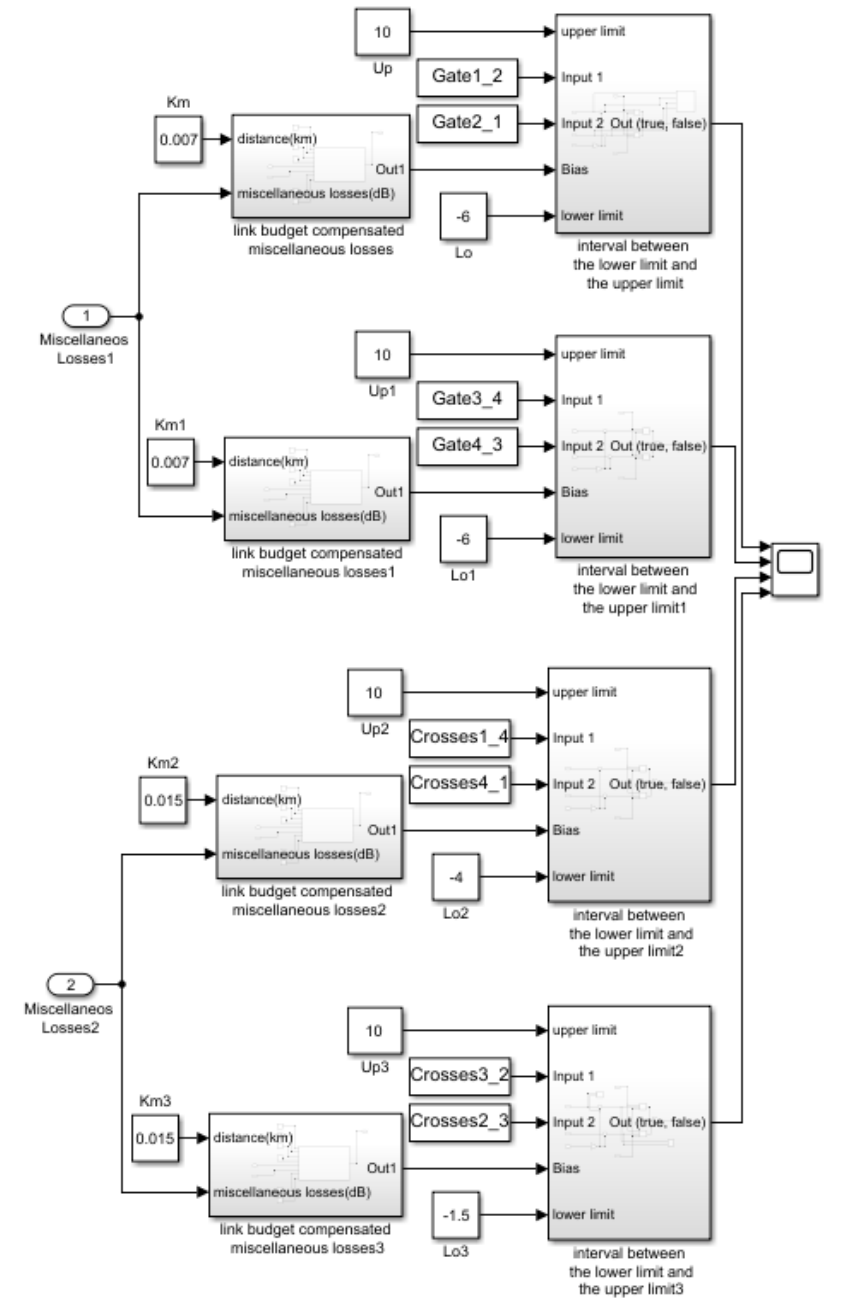
Figure 15. Simulink diagram for link budget compensated data analysis method.